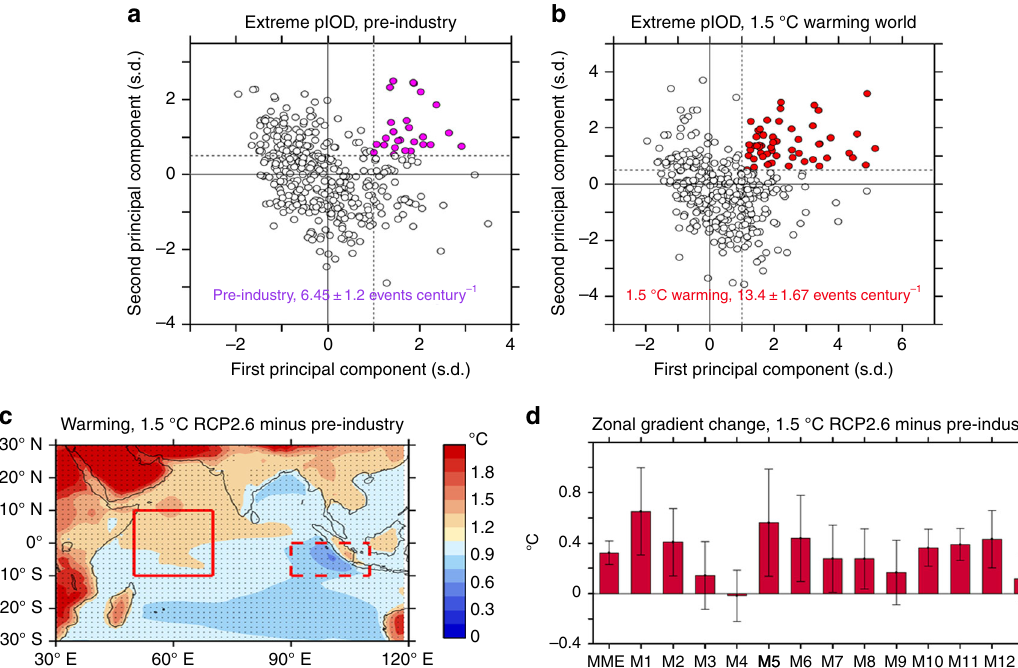
Fig. 2 Changes associated with 1.5 °C warming from the pre-industrial level. a , b Relationship between the fi rst and second principal component of rainfall EOF 31 conducted over the equatorial Indian Ocean (10° S – 10° N, 40° E – 100° E), for the pre-industrial (1869 – 1899) and the targeted 1.5 °C warming levels, respectively. The results are based on 13 available models that are able to generate extreme pIOD events 3 and can reach 1.5 °C warming under RCP2.6. The purple dots and red dots indicate extreme pIOD events for the pre-industrial and the targeted 1.5 °C warming levels, respectively. Frequency for each warming level is also indicated within each panel, with the 90% con fi dence intervals based on Poisson distribution. c Multi-model ensemble mean changes in surface temperature, created using the datasets listed in supplementary table 1. Stippled areas indicate regions where the changes are signi fi cant above the 90% con fi dence level, determined by a two-sided Student ’ s t -test. d Changes in mean zonal temperature gradient (red bars; red solid area minus red dashed area in c ) for multi-model ensemble average and each of the 13 models (M1 to M13). The error-bars correspond to the 90% con fi dence level (see Methods section). Results are based on boreal fall